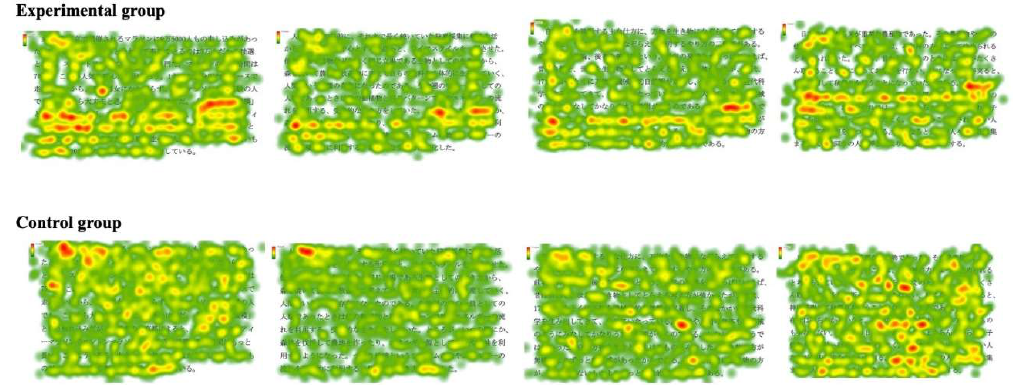
Figure 7. Heat map of the two groups in four Japanese reading articles.